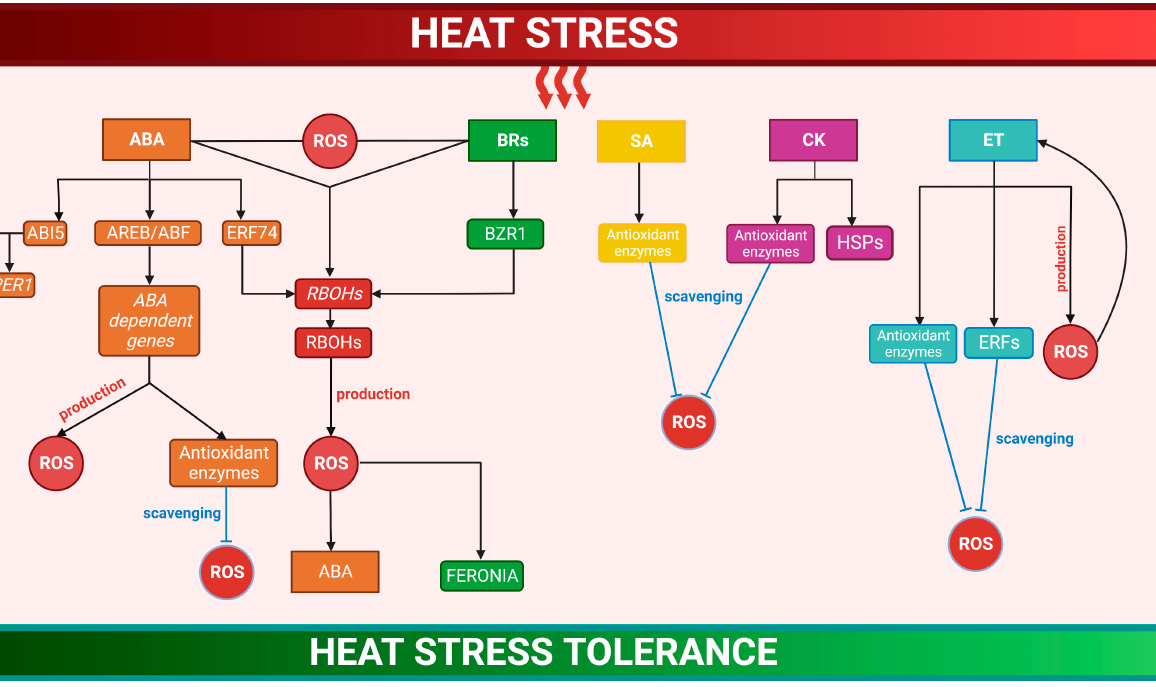
Figure 2. Crosstalk between signaling networks of reactive oxygen species and hormones in heat stress response. Under HS, ABA activates AREB/ABF transcription factors controlling ABA-dependent gene expression, stimulating ROS production, or improving antioxidant machinery. ABA-induced ERF74 also increases ROS production by RBOHs induction. The interaction of FCA with ABI5 increases thermotolerance through the transcriptional regulation of PER1. BRs, by activating RBOHs, stimulate a transient H 2 O 2 accumulation, which increases ABA levels resulting in additional rises in H 2 O 2 . In BR-mediated heat tolerance, the regulator BZR1 improves the production of ROS, which regulates the receptor-like kinase FERONIA. SA, CK, and ET enhance antioxidant systems, increasing ROS scavenging. In addition, CK stimulate HSPs. ROS can act in concert with ET in a self-intensifying feedback loop where ET stimulates H 2 O 2 accumulation, which in turn improves ET production. ERFs contribute to lower ROS accumulation, balancing redox homeostasis. (See more details in the text). Abbreviations: ABA, abscisic acid; AREB/ABF, ABRE-binding/ABRE-binding factors; ERF74, ethylene response factor 74; RBOH, respiratory burst oxidase homolog; FCA, flowering control locus A; ABI5, ABA-INSENSITIVE 5; PER1, 1-Cys peroxiredoxin; BRs, brassinosteroids; BZR1, brassinosteroid-regulated transcription factor 1; SA, salicylic acid; CK, cytokine; ET, ethylene; and ERF, ethylene response factors. Created with BioRender.com.; accessed on 20 February